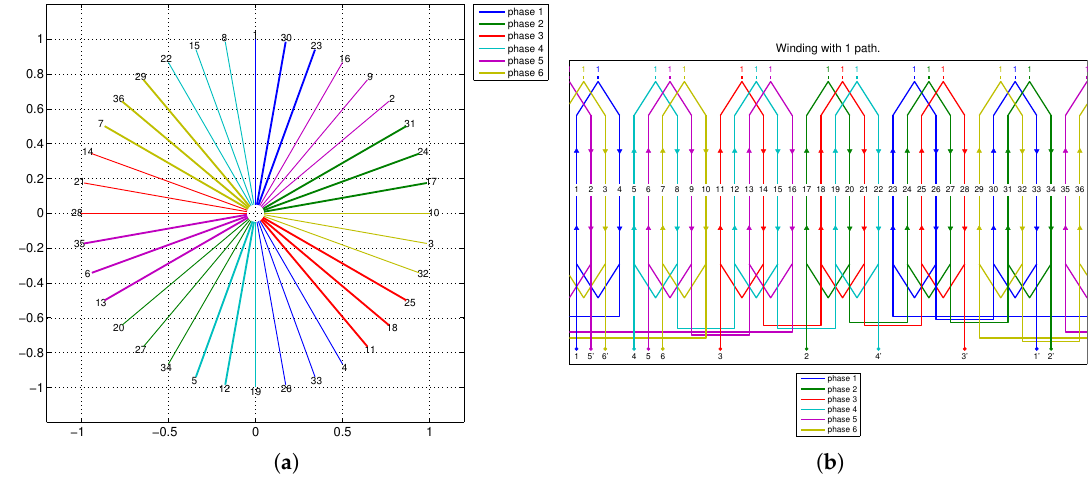
Figure 10. ( a ) EMF star and ( b ) winding scheme for a symmetrical single layer non-reduced winding with N = 36, m = 6, p = 5 and q = 3 / 5